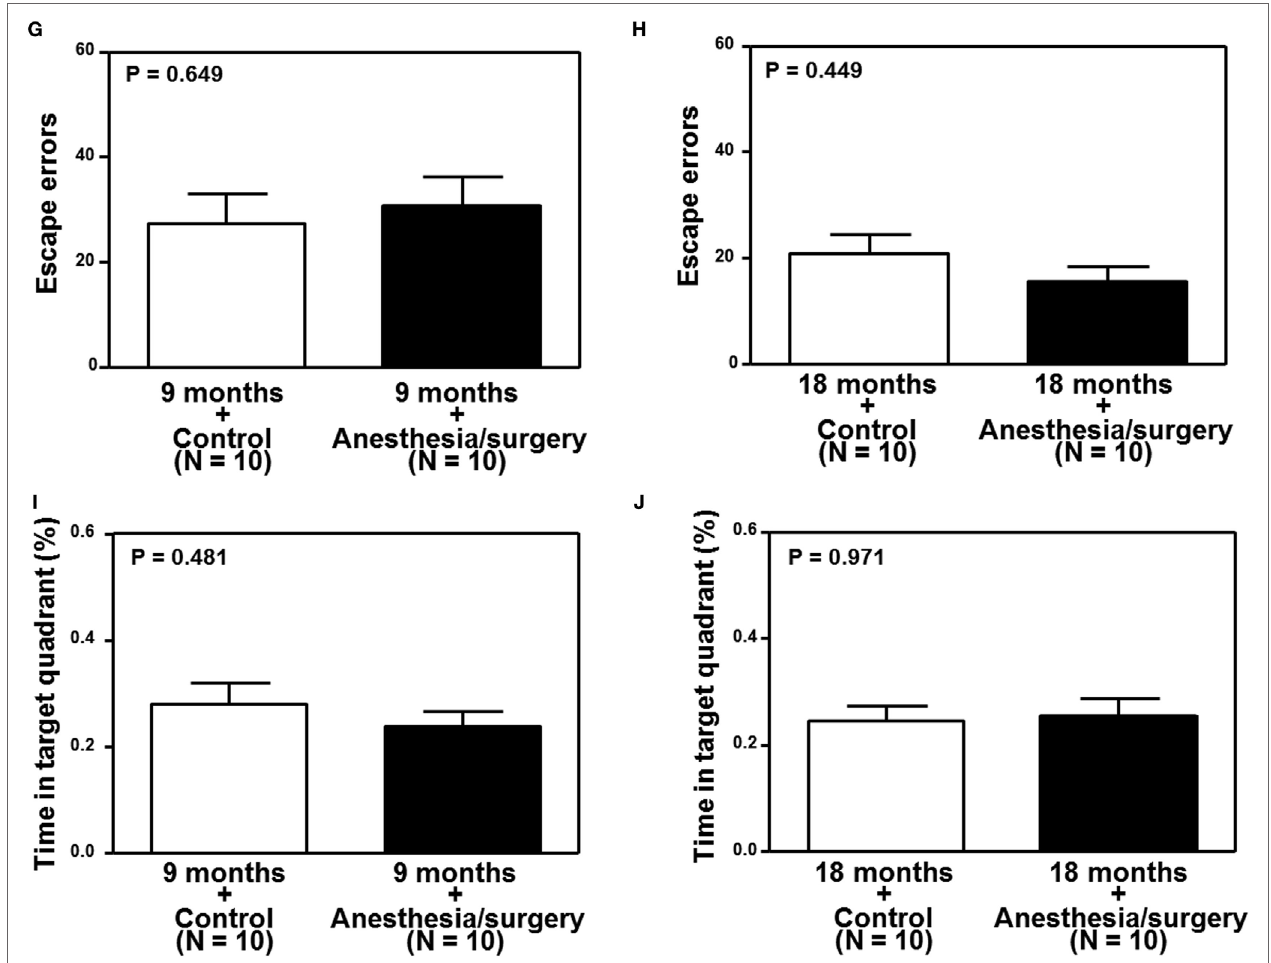
FigUre 6 | Effects of anesthesia/surgery on cognitive function in 9- and 18-month-old mice tested in Barnes maze. The anesthesia/surgery does not significantly change the escape latency (a) , escape distance (c) , escape speed (e) , escape errors (g) , and time in target quadrant (i) of Barnes maze as compared to the control condition in the 9-month-old mice. However, in the 18-month-old mice, the anesthesia/surgery significantly increases escape latency (B) and escape distance (D) of Barnes maze as compared to the control condition. The anesthesia/surgery does not significantly change the escape speed (F) , escape errors (h) , and time in target quadrant (J) of Barnes maze as compared to the control condition in the 18-month-old mice. N = 10 in the control condition group and N = 10 in the anesthesia/surgery